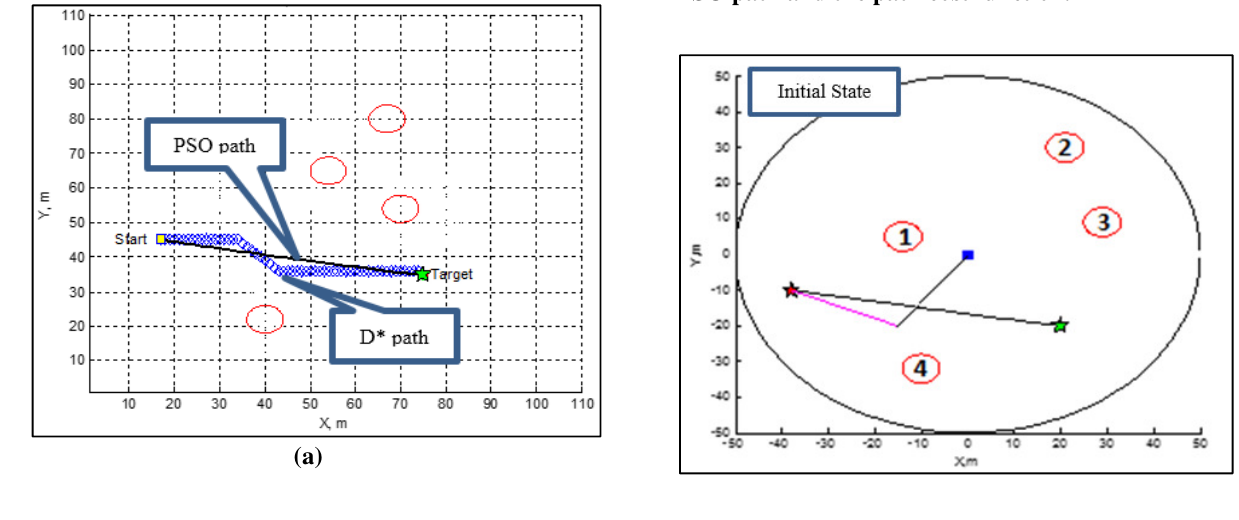
Fig. 7. The two-link robot arm result for the D* path. Fig. 8. (a) Represents final D* and (b) represents PSO path and the path cost